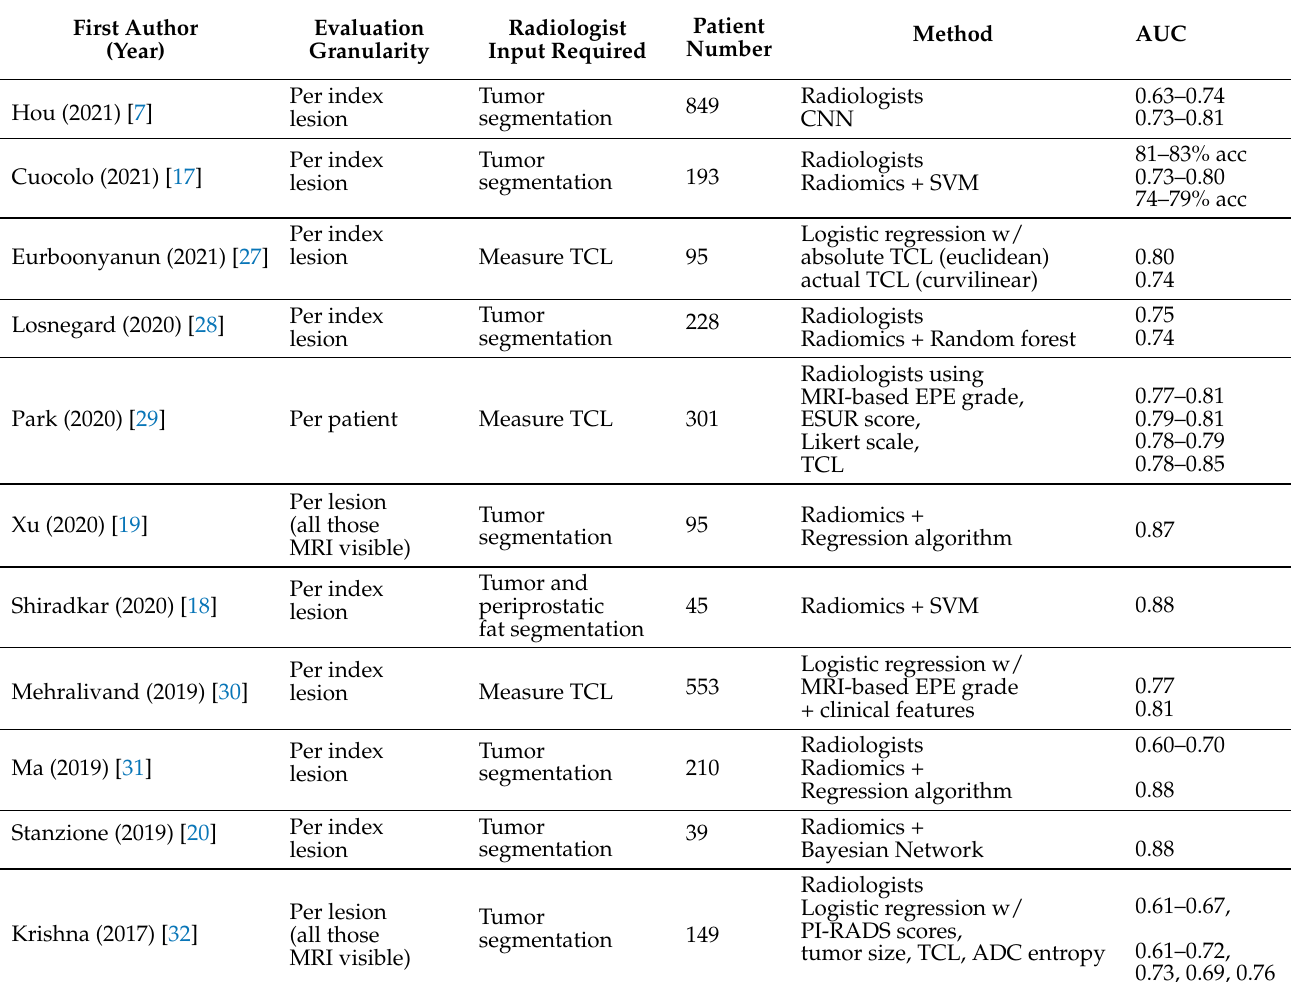
Table 1. Summary of previous studies predicting presence of extraprostatic extension on multipara- metric MRI. Abbreviations: EPE = extraprostatic extension; w/ = with; CNN = convolutional neural network; SVM = support vector machine; TCL = tumor–capsule contact line length (also known as capsular contact length); PI-RADS = Prostate Imaging-Reporting and Data System; ESUR = European Society of Urogenital Radiology; ADC = apparent diffusion